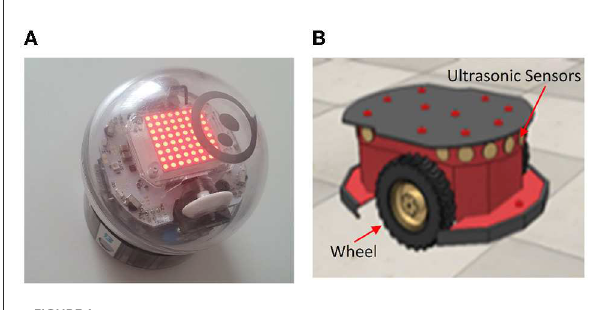
FIGURE1 Sphero BOLT and Pioneer 3DX (A, B) —the two robot platforms used in the experiments of this